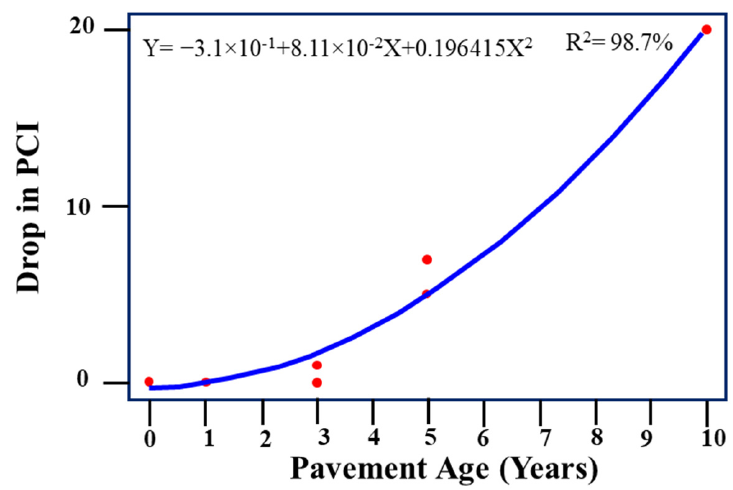
Figure 11. Effect of reconstruction on the deterioration of PCI for low traffic.